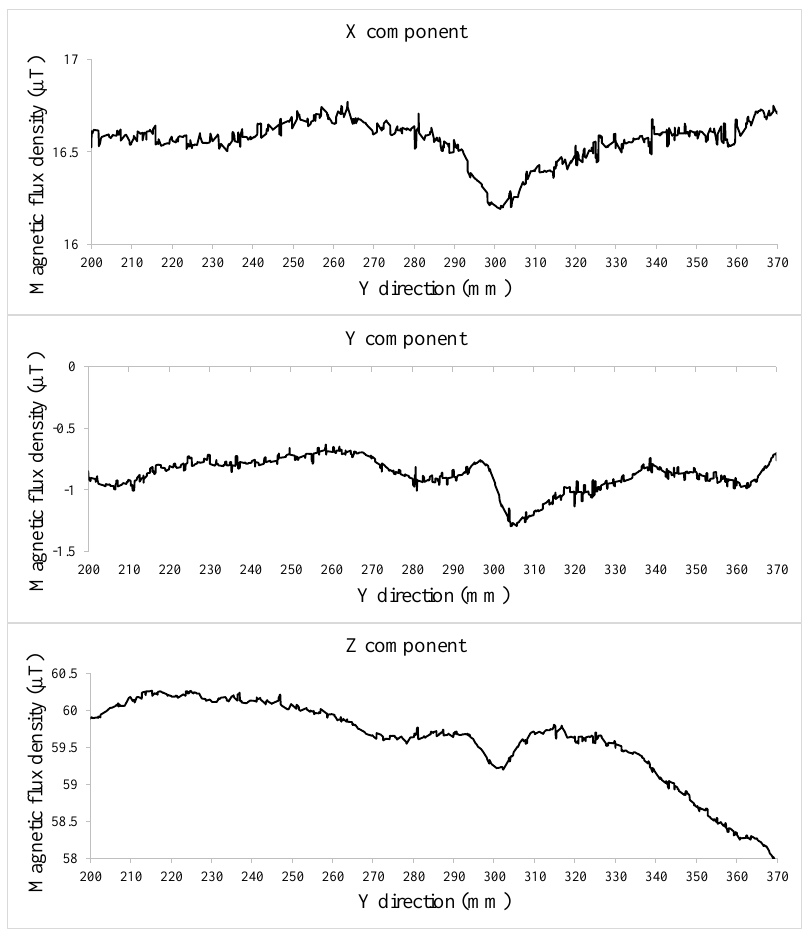
Figure 23. Values of different components (X, Y, and Z) of the magnetic flux densities in the Y direction, 16 mm from the center of the rebar (rebar mesh # 8 and box mesh # 5).